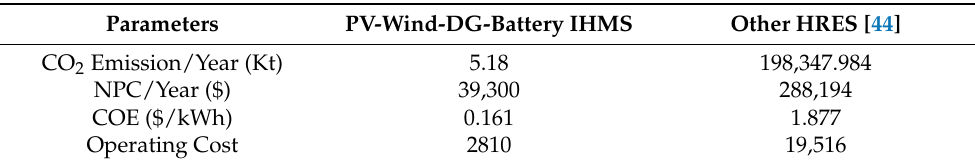
Table 2. Comparison of CO 2 emission, NPC, COE, and operating cost between the designed IHMS and other HRES.